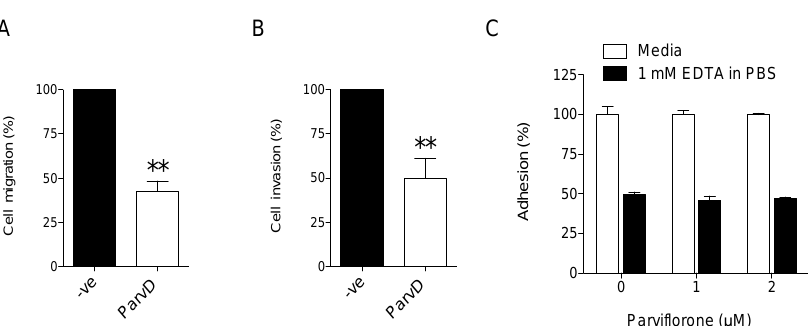
Figure 5. Impact of ParvD on cell migration, invasion, and detachment. Cell migration ( A ) and cell invasion ( B ) were evaluated using a transwell system. Results are expressed as mean values ± SD ( n = 3) ** p < 0.01 (Student’s t -test, relative to untreated cells). Cell adhesion was assessed using an EDTA-induced cell detachment assay ( C ). Results are expressed as mean values ± SD ( n = 2).